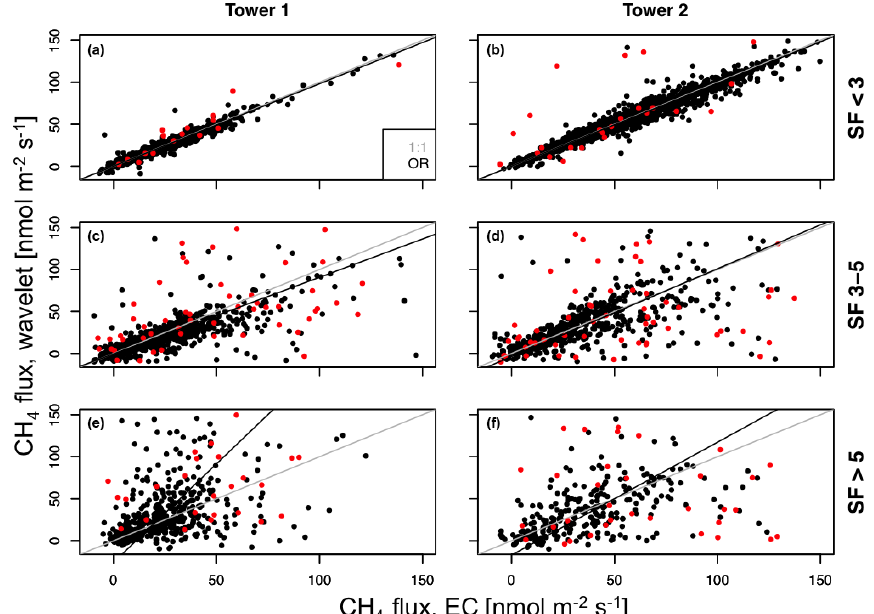
Figure A3. Impact of events on the direct intercomparison of half-hourly flux rates between wavelet and eddy-covariance processing methods, sorted by tower and stationarity flag (SF) category. The displayed dataset includes gap-filled data, where linear interpolation was used to fill gaps for the EC method under low stationarity. Fluxes influenced by events are plotted in red, while no-event cases are black. The thin grey line gives the 1:1 line, and the black line gives the fit of the orthogonal regression (OR)